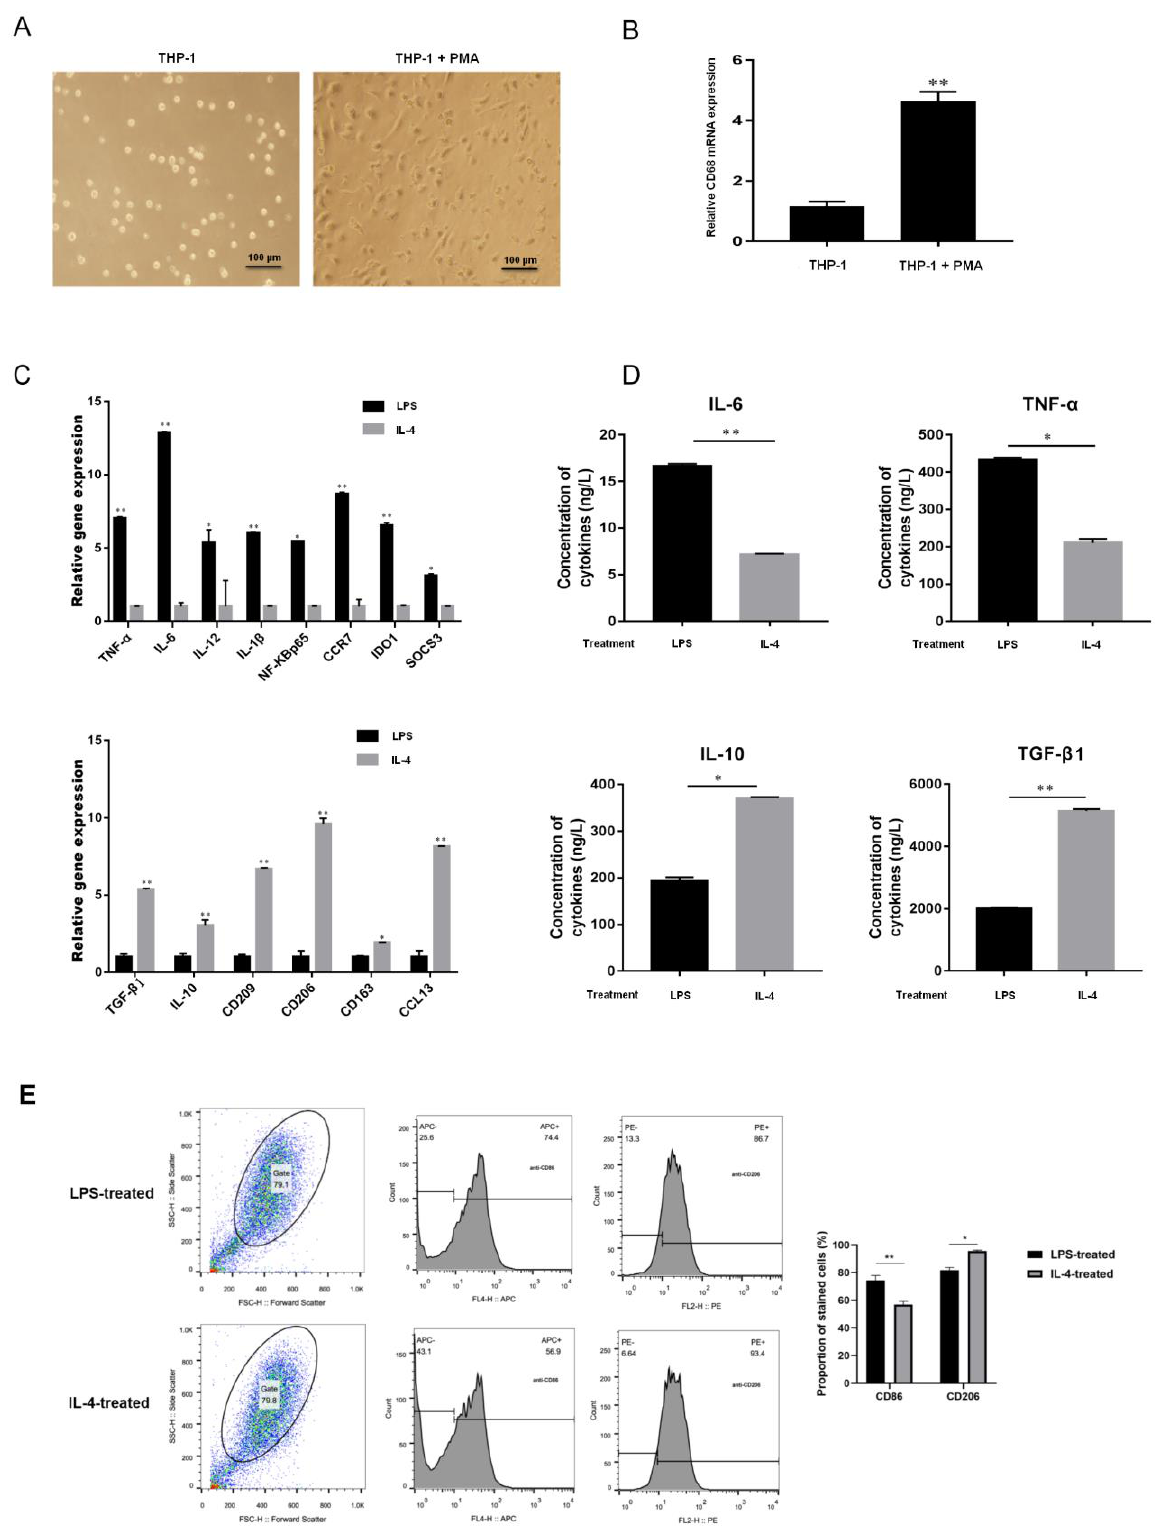
Figure 3. Identification of macrophages after M1- or M2-type polarization. ( A ) The morphology of THP-1 cells after PMA treatment (scale bar, 100 µ m). ( B ) The mRNA expression of CD86 in PMA-treated THP-1 cells as determined by q-RT-PCR. ( C ) The mRNA expression of macrophage markers of M1 (IL-6, IL-12, TNF- α , IL-1 β , NF- κ B P65, CCR7, IDO1, and SOCS3) and M2 (CD206, CD209, CD163, CCL13, IL-10, and TGF- β 1) as determined by q-RT-PCR. ( D ) The protein expression of the M1 and M2 macrophage markers IL-4, TNF- α , IL-10, and TGF- β 1 were measured by ELISA. ( E ) Flow cytometric identification of LPS- and IL-4-treated macrophages. * p < 0.05, ** p < 0.01.